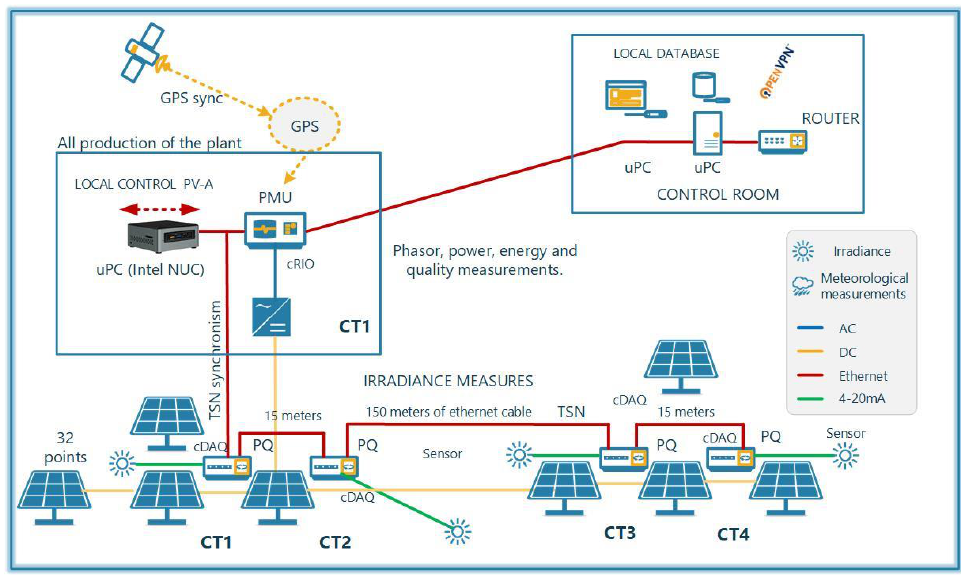
Figure 1. Architecture of the distributed measurement system for the Cruz del Doctor plant.